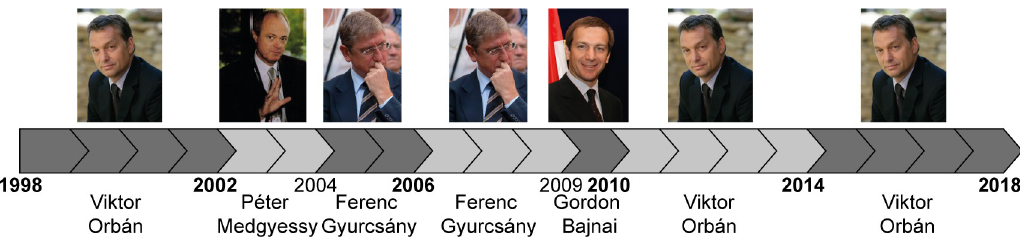
Fig 1. Timeline of parliamentary cycles and prime ministers in Hungary from 1998 to 2018. The bottom line shows the name of the PMs and years of change in PM and/or the years of parliamentary elections (the later are in bold). All images are downloaded from Wikimedia Commons (commons.wikimedia.org; Orban Viktor Portrait.jpg, kormany.hu, 2010, CC BY-SA 2.5; Medgyessy Pe´ter 2002.jpg, Tama´s Griechisch, 2002, CC BY-SA 4.0; Gyurcsa´ny and Medgyessy (Aug 2014).jpg, Tibor Ve´gh, 2014, CC BY 3.0; Bajnai Jerusalem.jpg, Itzike, derivative work by Qorilla, 2009, CC BY-SA 3.0).